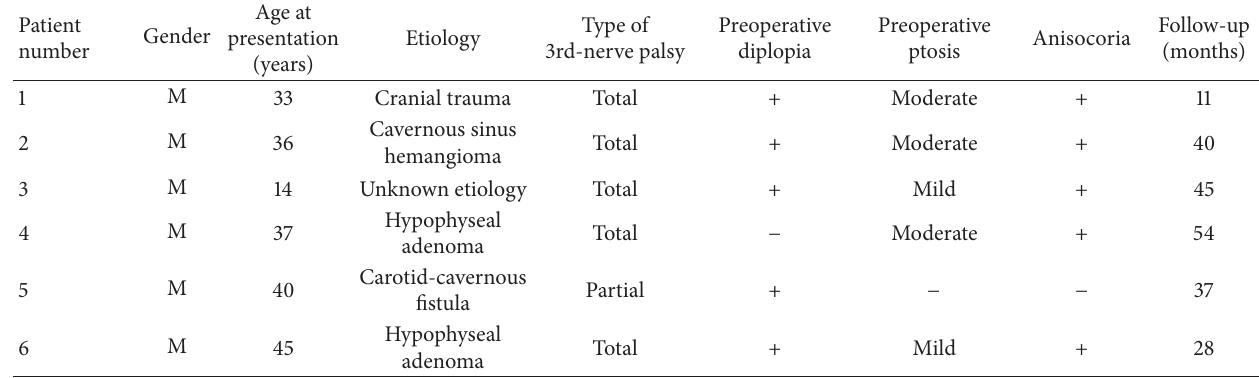
Table 1: Demographic features, etiology, and clinical features of patients with total third-nerve